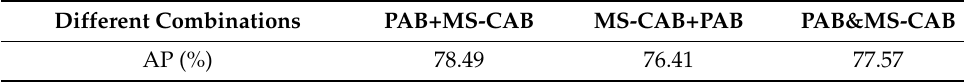
Table 6. Influence of attention combination on detection results.